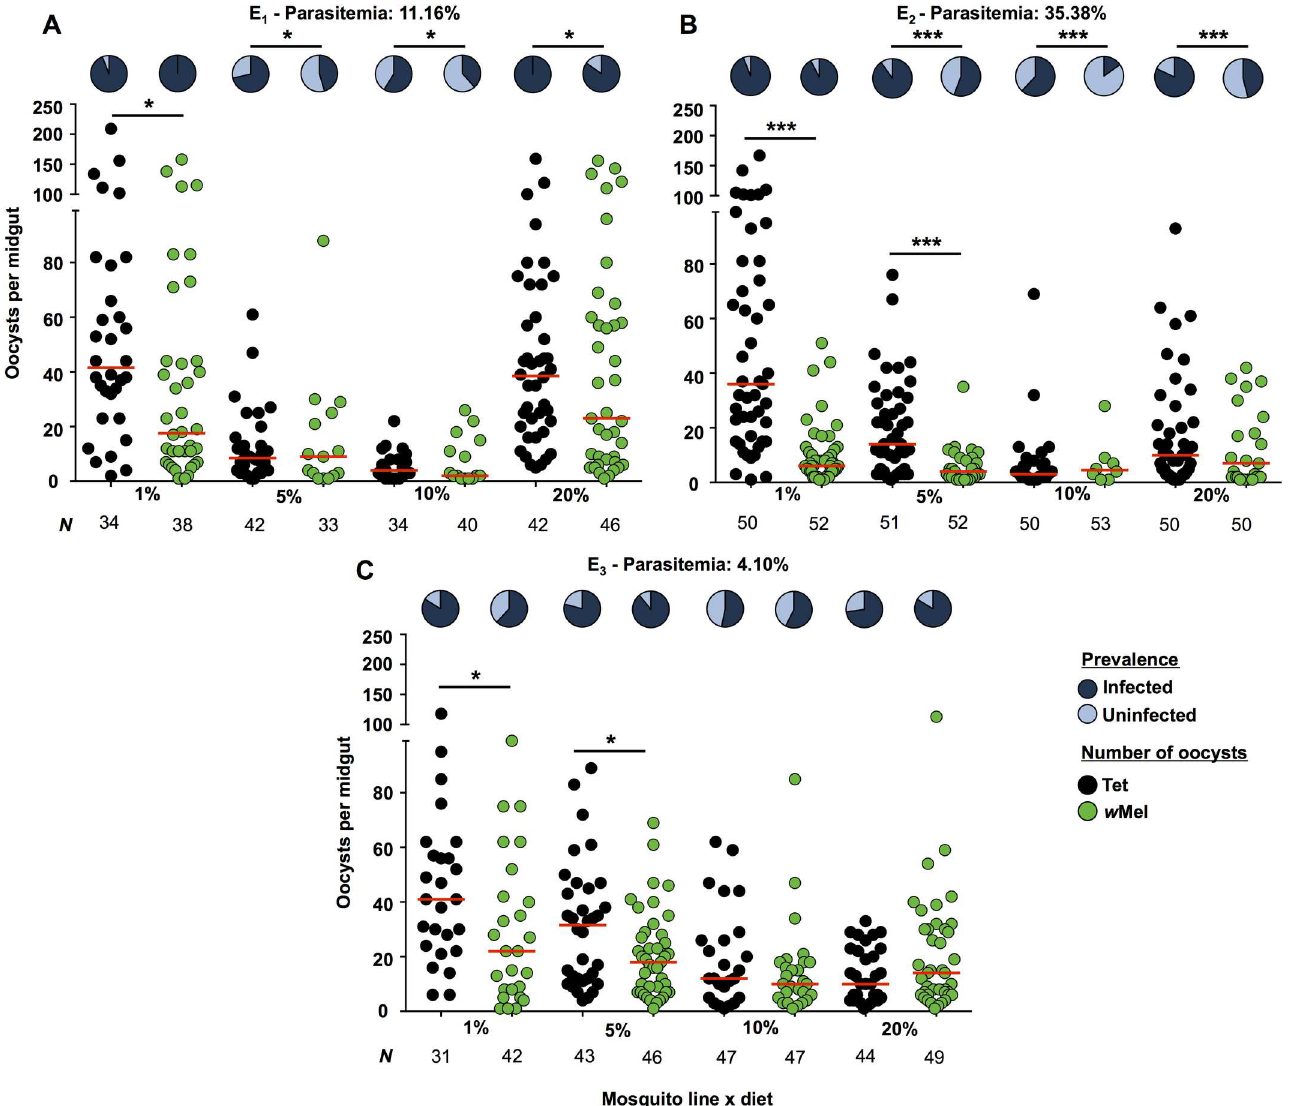
Fig 2. Interferenceagainst P . gallinaceum in w Mel-infected Ae . aegypti fed on different carbohydrate regimes. In three experimental replicates (E 1 — A , E 2 — B , E 3 — C ), w Mel (+ Wolb )and Tet (- Wolb )mosquitoeswere fed one of four different carbohydrate regimes and then fed on a single Plasmodium gallinaceum -infected chicken. Prevalence of infectionwas determined by countingthe proportionof mosquito’sthat had oocysts in their midguts at 7–8 days post-infection (pie charts: proportioninfected—dark blue, proportionuninfected—light blue). Intensity of infectionwas calculatedas the numberof oocysts per midgut for Tet (black circles), and w Mel mosquitoes(green circles). Red bars represent medianoocysts for P . gallinaceum -infected mosquitoes. P values: * < 0.05, *** < 0.001, Prevalence—Fisher’s exact test, Intensity—Mann Whitney U